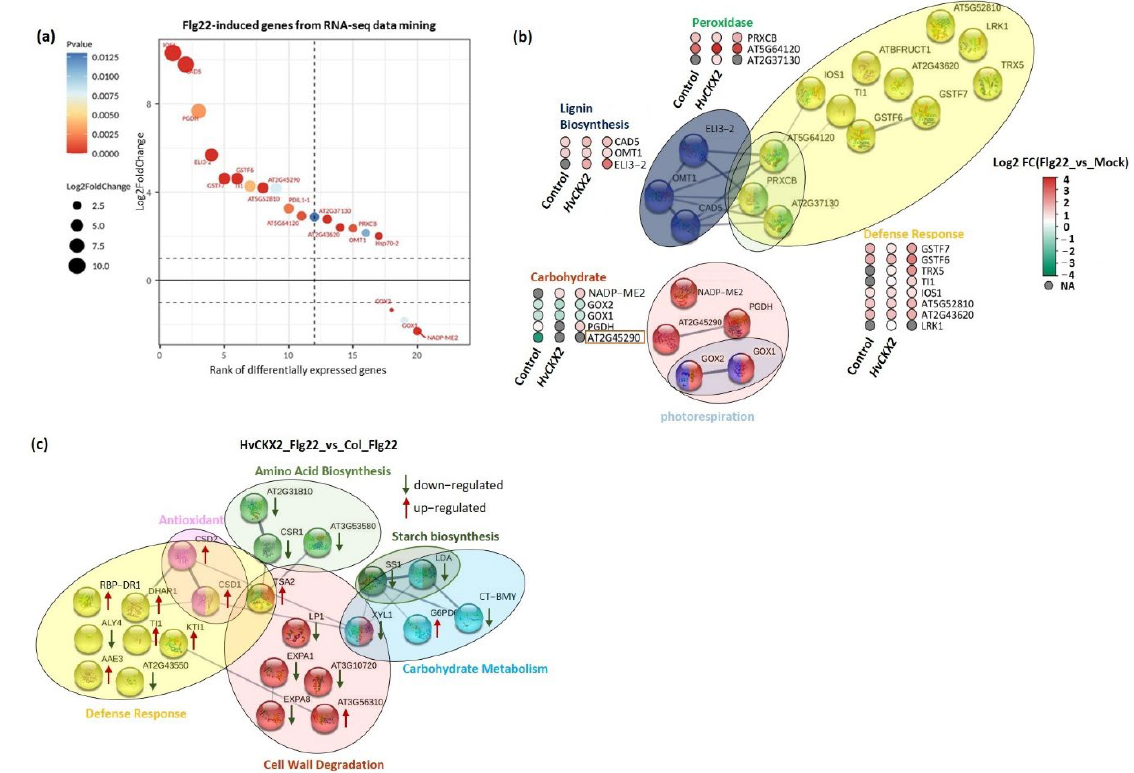
Figure 7. ( a ) Expression of flg22-induced genes encoding the flg22-responsive proteins obtained from RNA data mining. ( b , c ) Protein–protein associations produced with STRING database which present the functional partnerships between significant flg22-responsive proteins and CK pool-dependent proteins involved in plant defence responses. The heatmaps represent increased (red) or decreased (green) abundance of specific proteins in HvCKX2 plants compared with their corresponding controls.